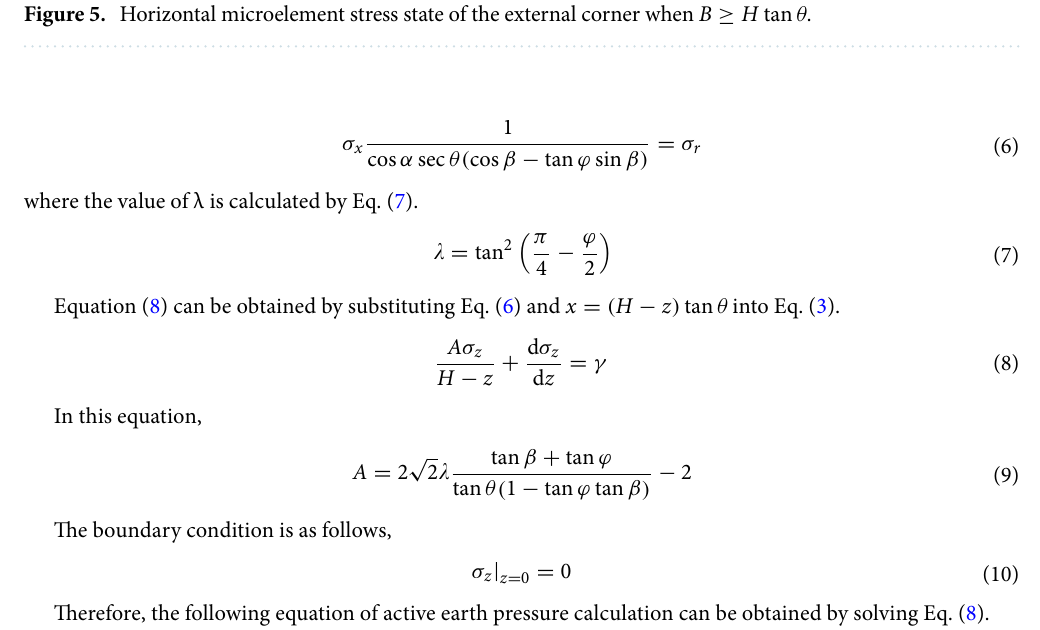
Figure 5. Horizontal microelement stress state of the external corner when B